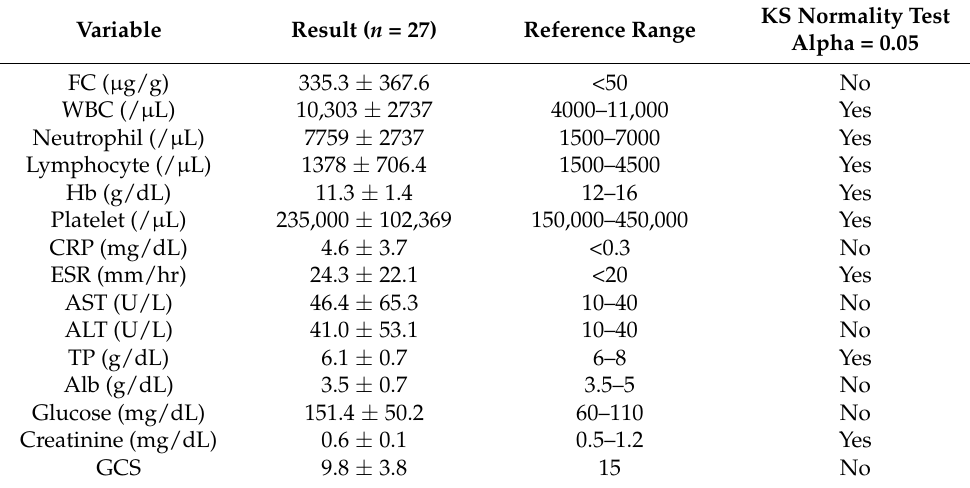
Table 3. Laboratory characteristics and GCS of the stroke